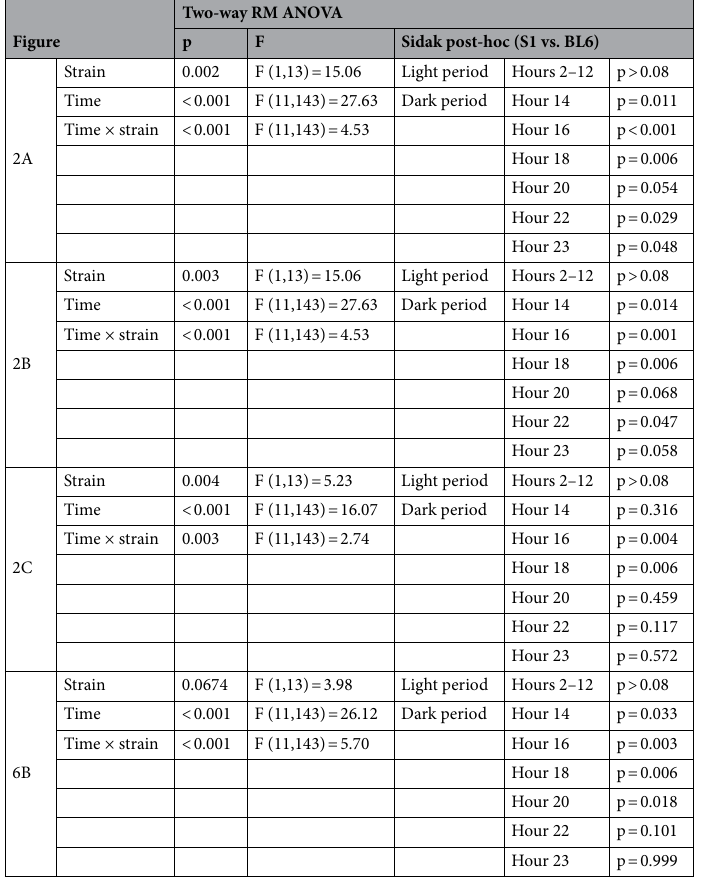
Table 1. Statistical results of Two-way RM ANOVAs with Sidak post-hoc test.